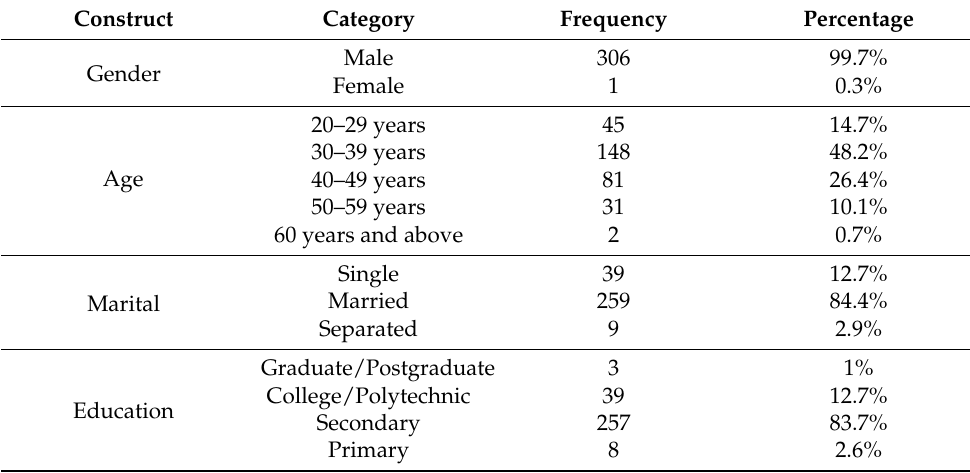
Table 2. Demographic variables ( n =